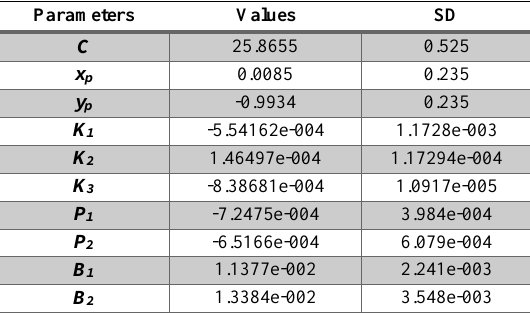
Figure 5: 3D dense reference